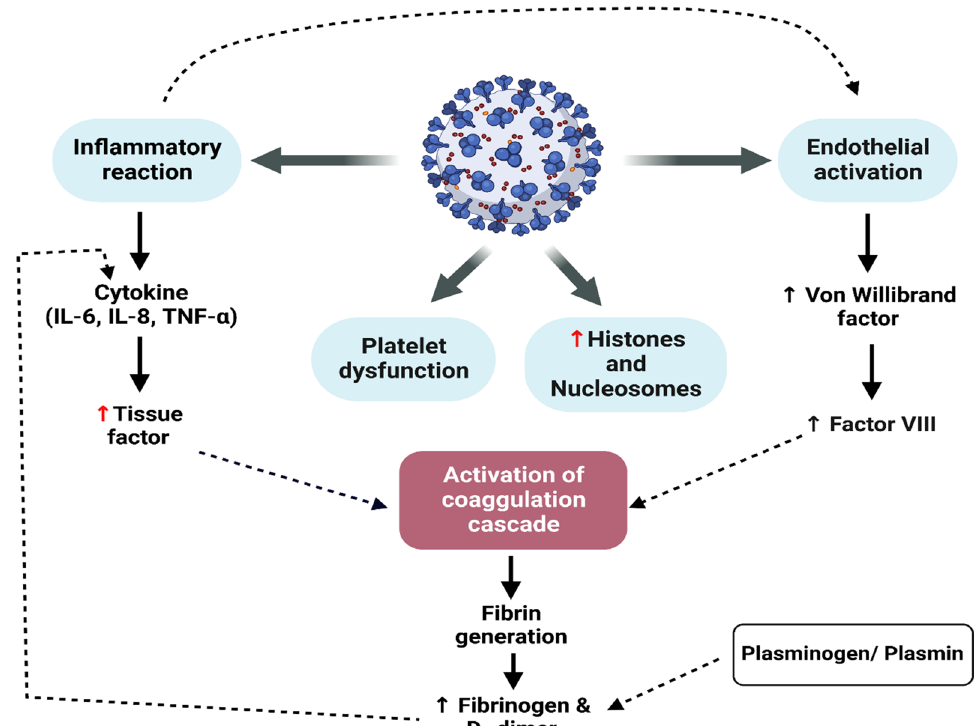
Fig. 4 Coagulopathy in Covid‑19: SARS‑CoV‑2 infection leads to inflammatory reactions, endothelial dysfunction, platelet dysfunction and increase release of histone and nucleosomes. These changes trigger activation of coagulation cascade with thrombotic disorders and increase D‑dimer. Fibrinogen and D‑dimer activate release of pro‑inflammatory